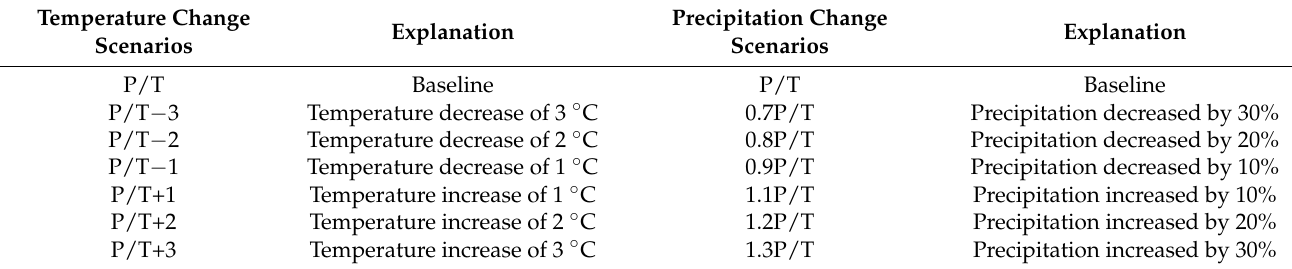
Table 3. The climate change